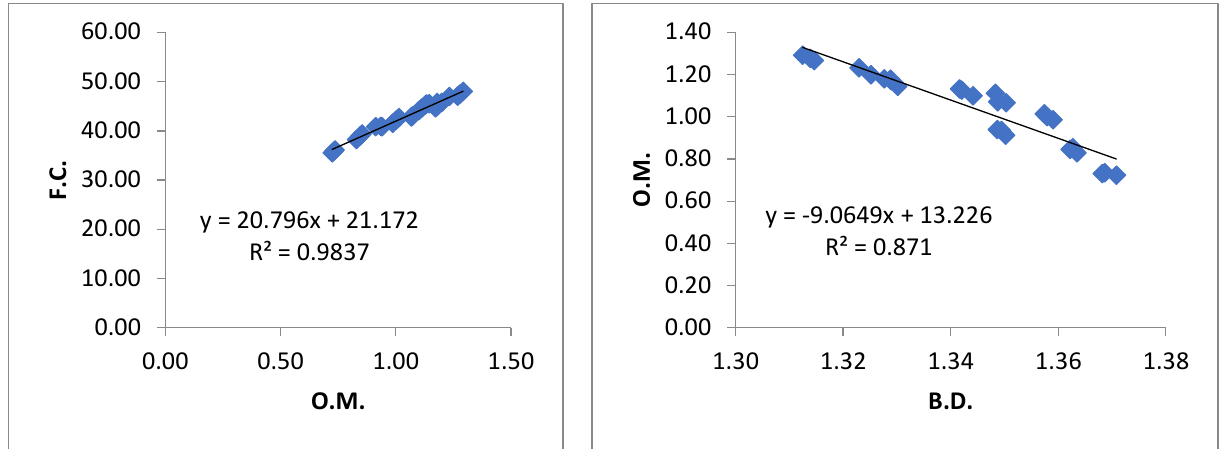
Figure 8. A linear relationship between soil organic matter, field capacity, and bulk density. The data represent averaged values of two seasons under all treatments.